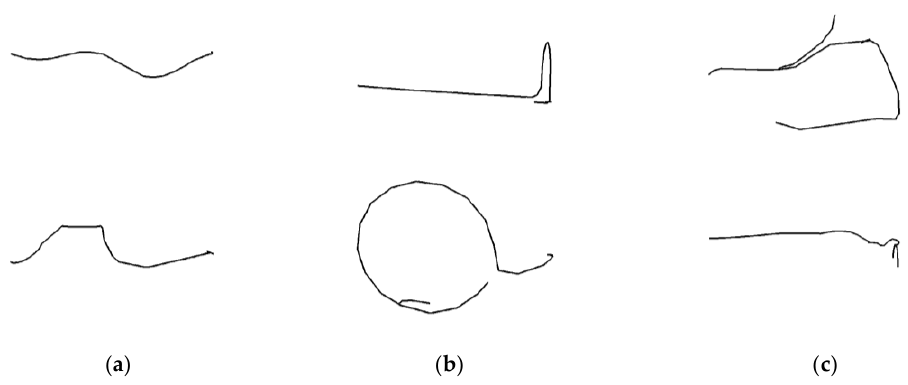
Figure 1. The 2D projections of geometric morphologies of the C. elegans neurons. ( a ) Interneuron, ( b ) Motoneuron, ( c ) Somatic neuron.